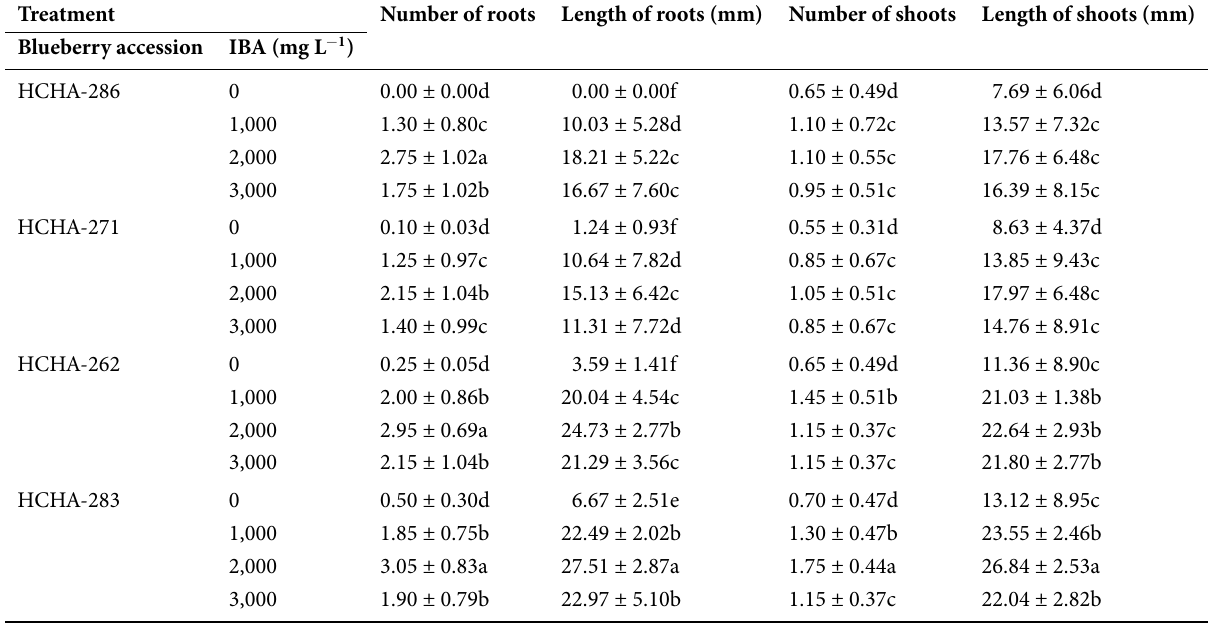
Table 2 Effects of indole-3-butyric acid (IBA) on the numbers and lengths of roots and shoots (± standard deviation; SD ) of five wild blueberry